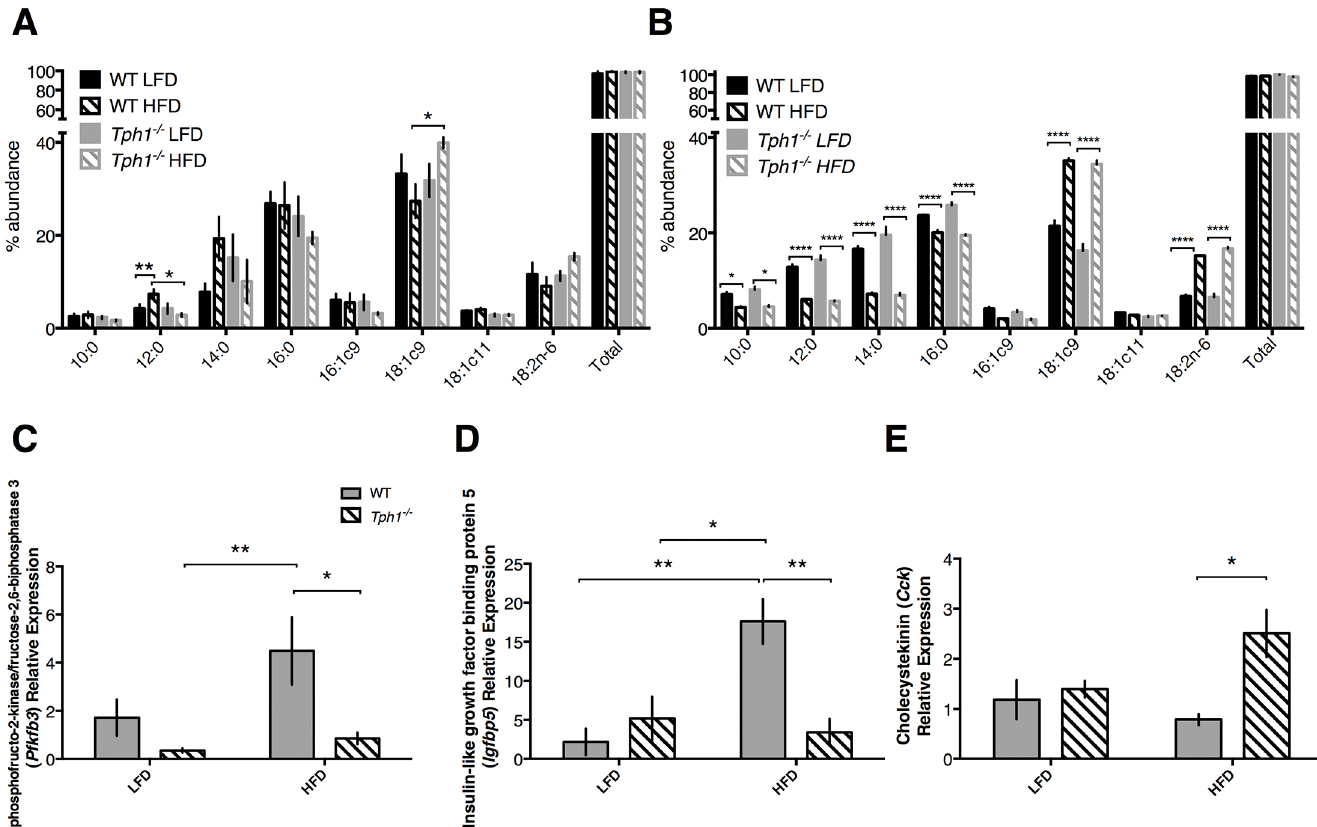
Fig 4. Milk fatty acid composition and mRNA expression of fat-related genes were altered in response to high fat or low fat diet fed to wild type or Tph1 deficient dams. Wild type or Tph1 deficient dams were either fed a high fat or low fat diet throughout pregnancy and lactation. Shown are the effects on ( A ) relative abundance of various fatty acids in milk from early lactation, ( B ) relative abundance of various fatty acids in milk on day 10 of lactation, ( C ) mammary gland mRNA expression of 6-phosphofructo-2-kinase/fructose-2,6-bisphosphatase 3, ( D ) mammary gland mRNA expression of insulin-like growth factor binding protein 5, ( E ) mammary gland mRNA expression of cholecystekinin. Values are means ± SEMs. Stars indicate statistical significance between groups ( * = 0.05 < P < 0.01, ** = 0.01 < P < 0.001, *** = 0.001 < P < 0.0001, **** = P < 0.0001). WT, wild type; Tph1 -/- , Tph1 deficient; LFD, low fat diet; HFD, high fat diet.